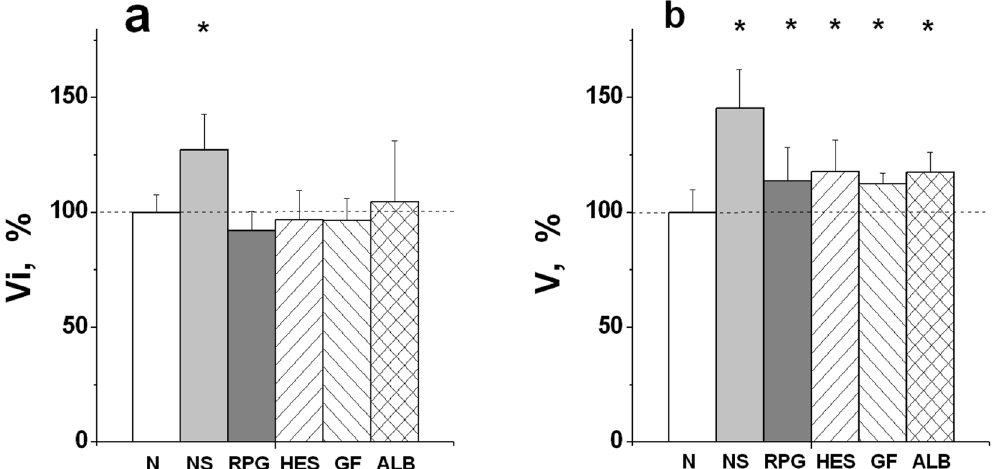
Figure 6. Clot growth rates in undiluted plasma (N) and in plasma diluted two-fold with various PEs. The initial ( a ) and stationary ( b ) spatial clot growth rates are presented. Coagulation was activated by TF (an extrinsic pathway). The values of Vi and V in undiluted plasma were accepted as 100%. The following PEs were used for dilution (see legend to Fig. 1): NS, RPG, HES, GF, and ALB. The mean values ± SD are presented. * Difference between undiluted and diluted plasma is significant (ANOVA and paired t-test of Student, P < 0.05 , n = 14 for ALB and n = 8 for all the other